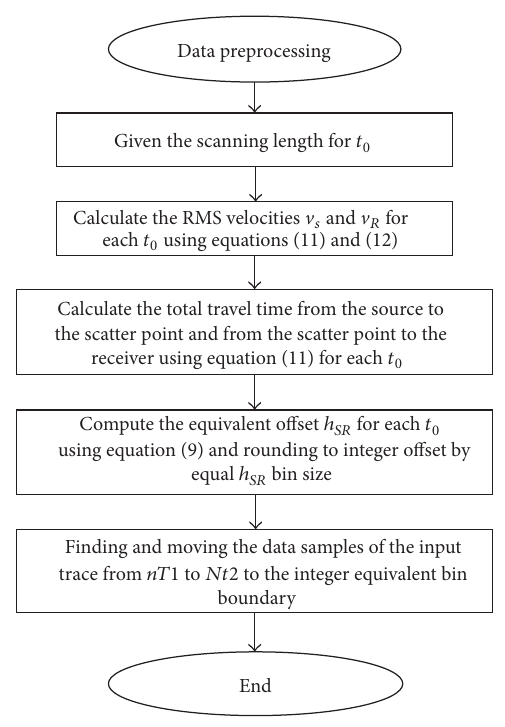
Figure 5: The workflow of the forming of the CSP gather for the rugged